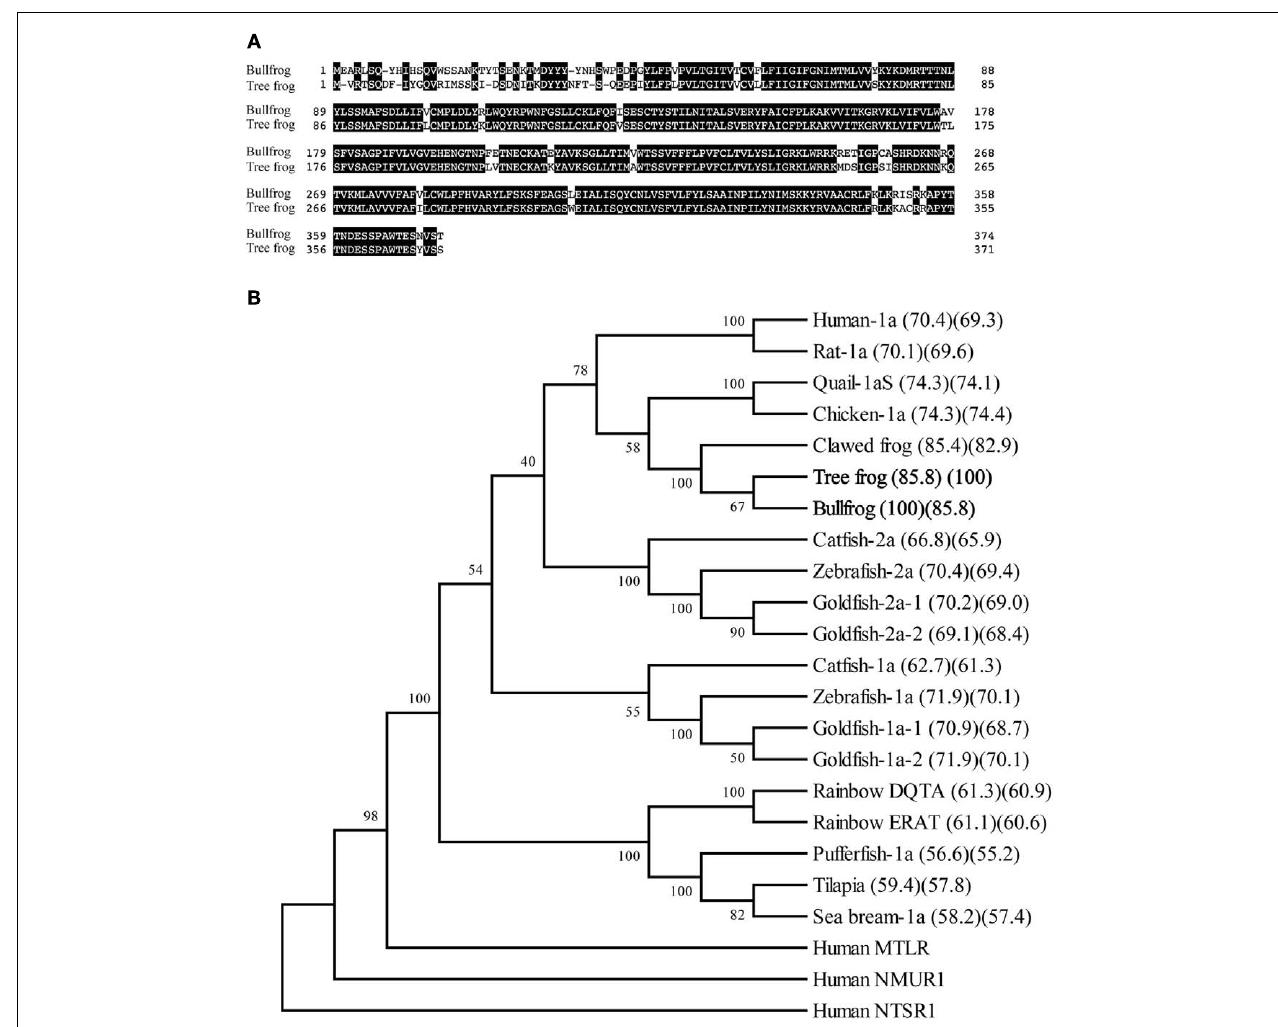
receptor-1 (NTSR1) were included as on out-group.The numbers at branch points represent bootstrap values (1000 repetitions).The value in parenthesis indicates amino acid sequence identity to bullfrog (left) and tree frog (right). Amino acid sequences except those indicated in Figure 3 are available in the DDBJ/EMBL/GenBank databases: human MTLR (NM_001507), human NMUR1 (NM_006056), human NTSR1